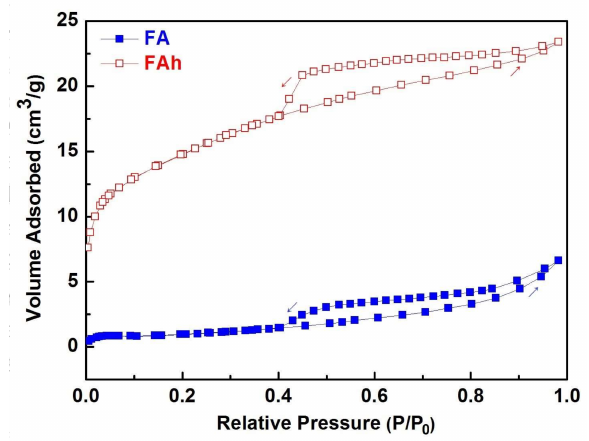
Figure 3. N 2 adsorption-desorption isotherms of FA and